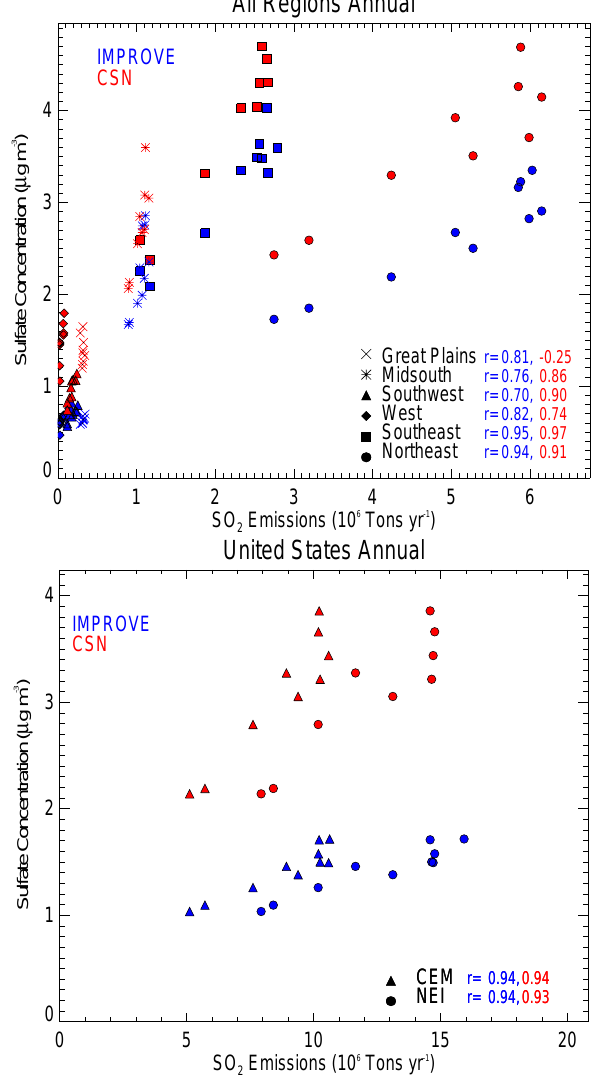
Fig. 10. (a) Regional annual mean short-term particulate sulfate ion concentration (µg m − 3 ) from IMPROVE and CSN versus an- nual total power plant SO 2 emissions (million t yr − 1 ) from con- tinuous emission monitoring (CEM) power plants. (b) US annual mean short-term sulfate ion concentration (µg m − 3 ) for IMPROVE and CSN versus annual total SO 2 emissions (million tons yr − 1 ) from continuous emission monitoring (CEM) power plants and the National Emission Inventory (NEI). Correlation coefficients ( r ) are listed in blue for IMPROVE and red for CSN and are 99% confident for values above 0.77 (IMPROVE) and 0.80 (CSN).